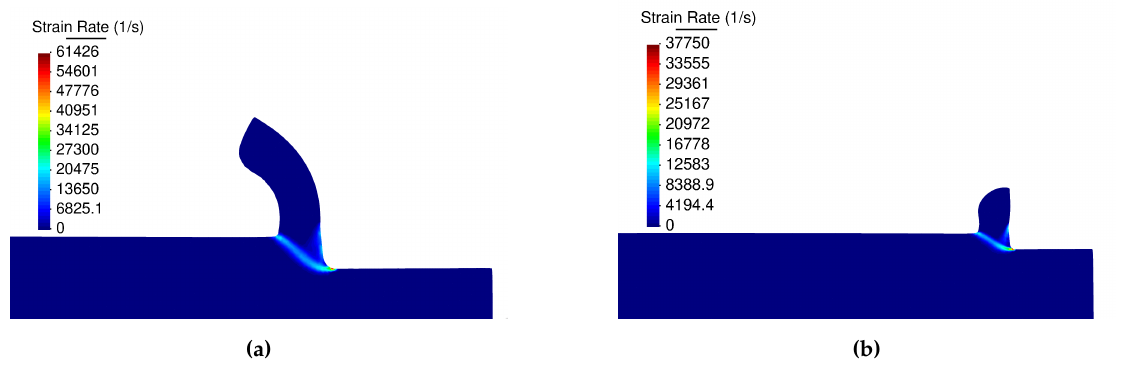
Figure 16. Plastic strain rate; ( a ) the dislocation density, ( b ) the Johnson-Cook model.